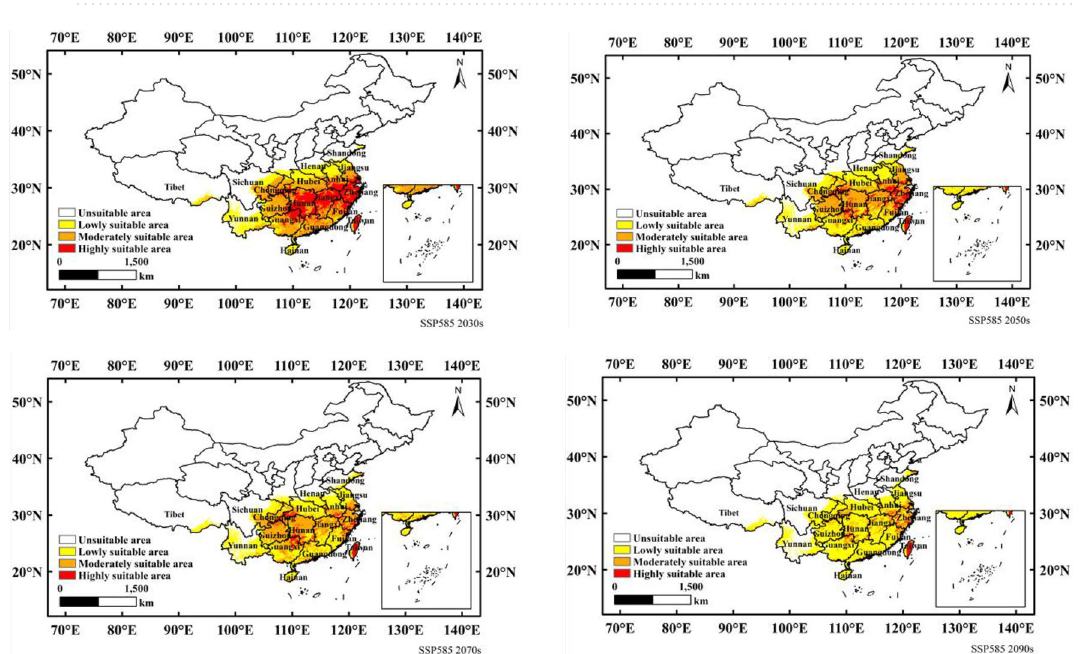
Figure 7. Potential suitable distribution of N. californicus in China based on MaxEnt under scenario of SSP585. Created in ESRI ArcMap 10.8.1 (https:// suppo rt. esri. com/ en/ Produ cts/ Deskt op/ arcgis- deskt op/